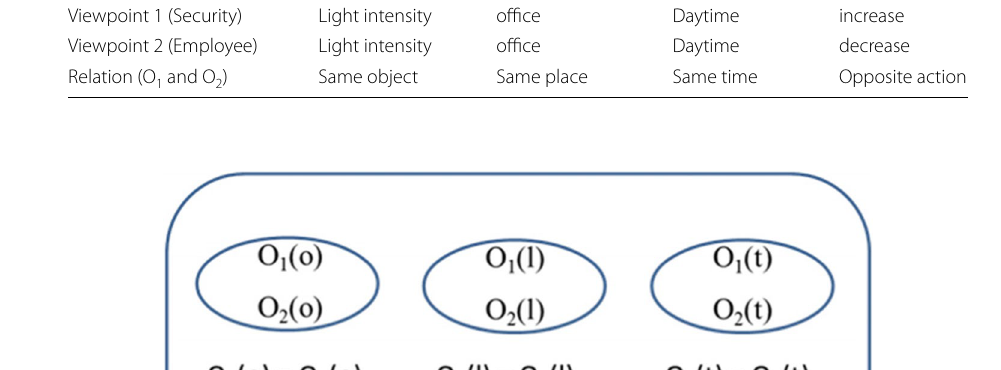
Table 2 Conflict situation analysis from example 1 Scenarios Object (what) Place (where) When (time) Action (how) Viewpoint 1 (Security)